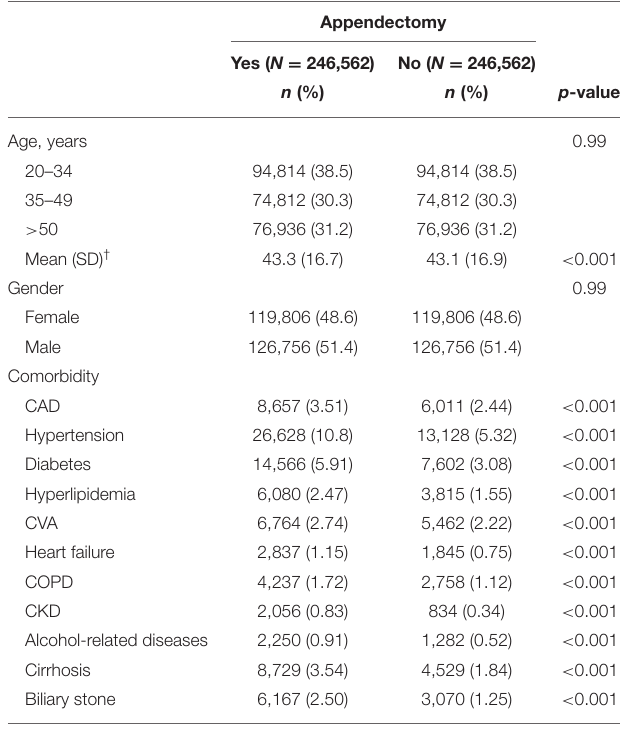
TABLE 1 | Comparison of demographics and comorbidities between patients with and without appendectomy.